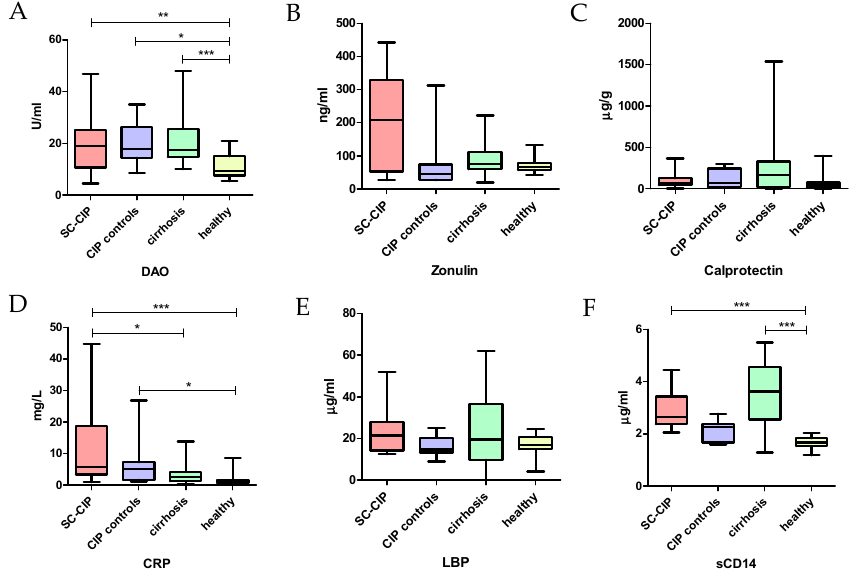
Figure 6. Boxplots for markers of gut permeability, bacterial translocation and intestinal and systemic inflammation. ( A ) diaminoxidase ( B ) zonulin ( C ) calprotectin ( D ) c-reactive protein ( E ) lipopolysaccharide-binding protein ( F ) soluble cluster of differentiation 14. SC-CIP (red), CIP controls (violet), cirrhosis (green), healthy (yellow). Significances are indicated with bars and stars within the diagrams. * p ≤ 0.05; ** p ≤ 0.01; *** p ≤ 0.001. For statistical analysis, analysis of variance (ANOVA) with Bonferroni correction was used; DAO = diaminoxidase; CRP = c-reactive protein; LBP = lipopolysaccharide-binding protein; sCD14 = soluble cluster of di ff erentiation